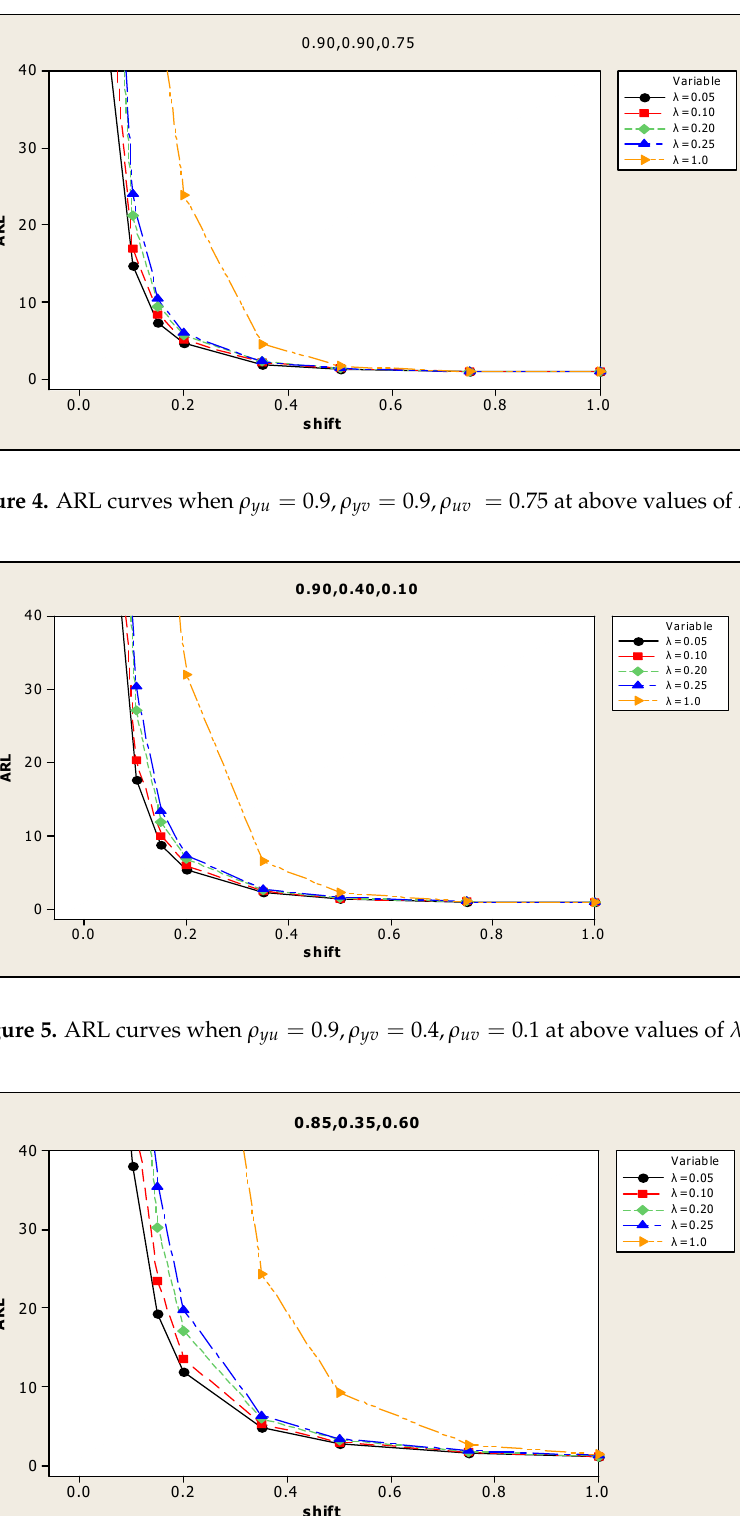
Figure 6. ARL curves when ρ yu = 0.85, ρ yv = 0.35, ρ uv = 0.60 at above values of λ